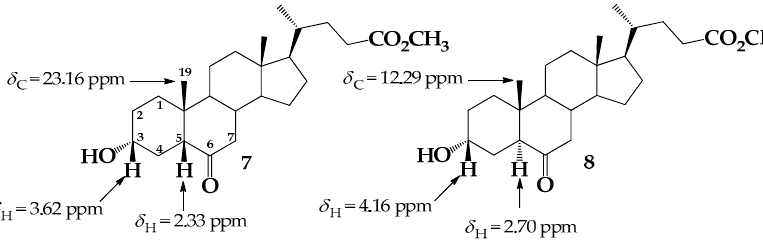
Figure 2. Major differences observed in the 1 H- and 13 C-NMR data of compounds 7 and 8 , associated with the change from the 5 β -cholestan to 5 α -cholestan skeleton (A/B ring cis for trans